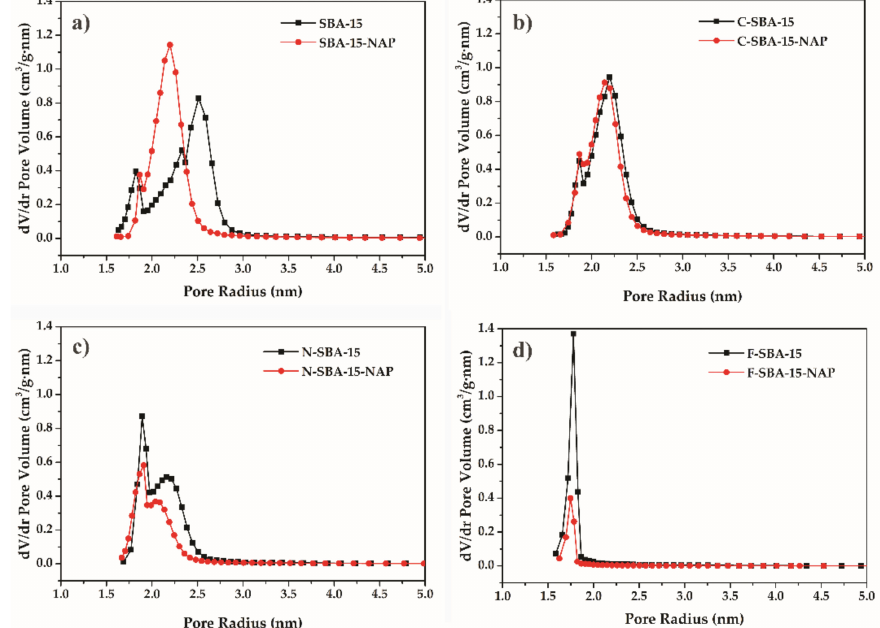
Figure 3. BJH pore size distribution of ( a ) SBA-15 and SBA-15-NAP, ( b ) C-SBA-15 and C-SBA-15-NAP, ( c ) N-SBA-15 and N-SBA-15-NAP, ( d ) F-SBA-15 and